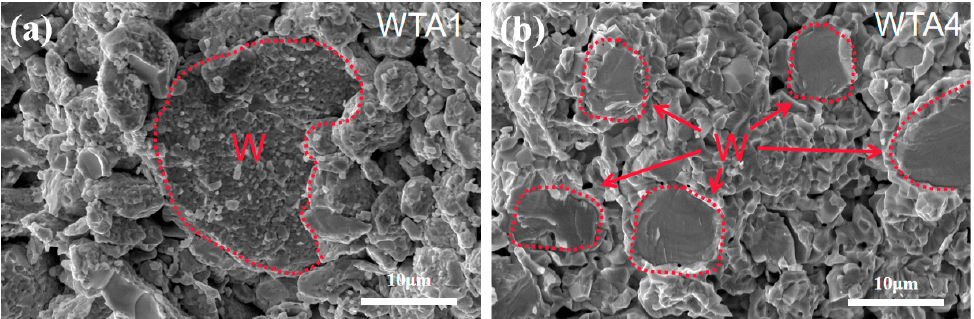
Figure 3. Fracture surfaces of (a) WTA1 and (b)